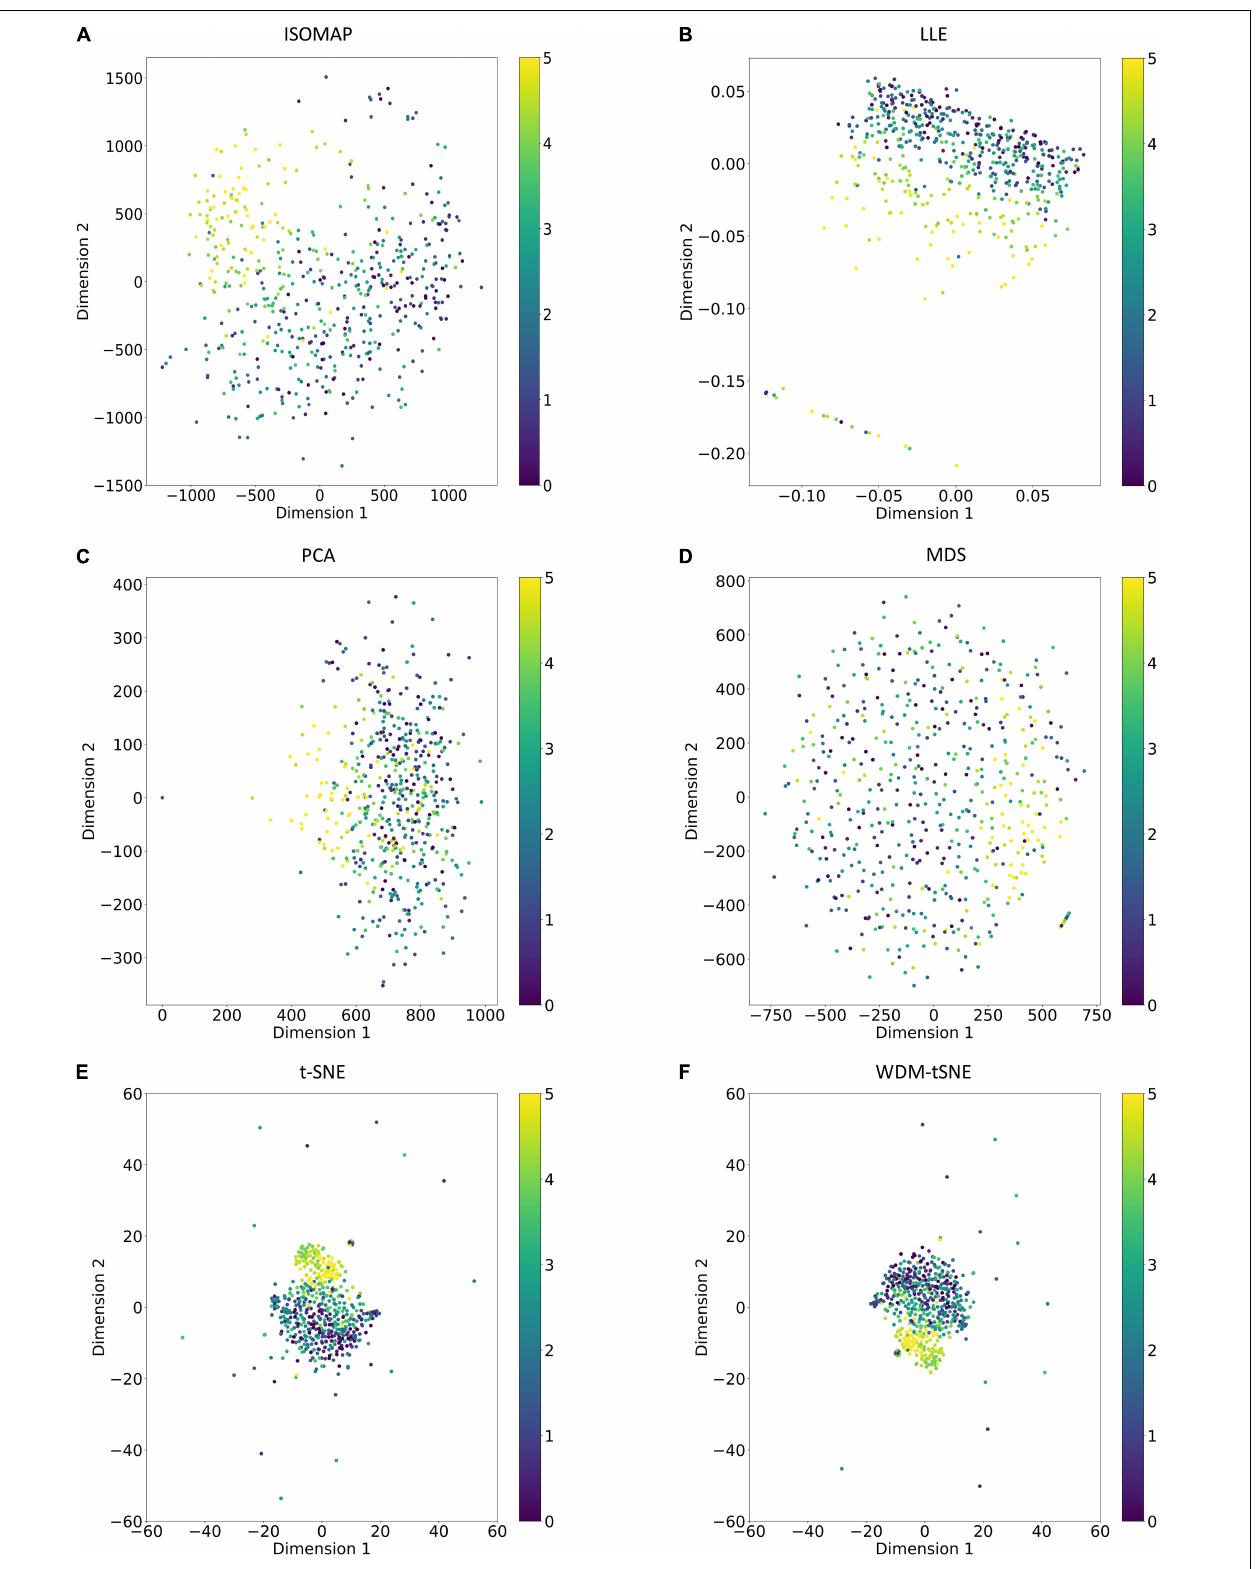
Frontiers in Plant Science |